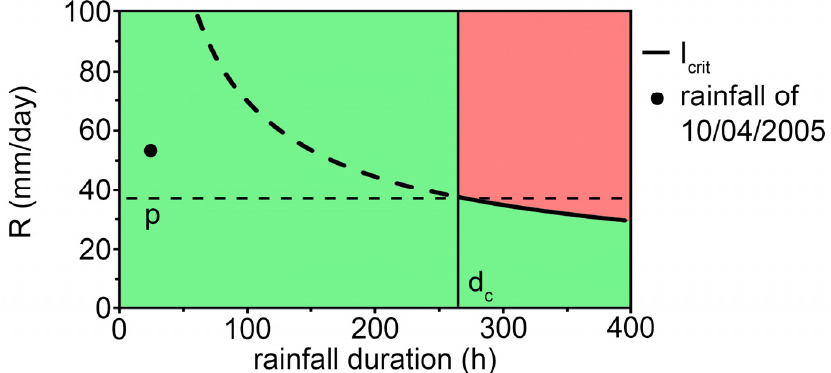
Figure 8. Comparison between the rainfall event recorded on 10 April 2005 and the critical curve calculated at the depth of 0.80 m.